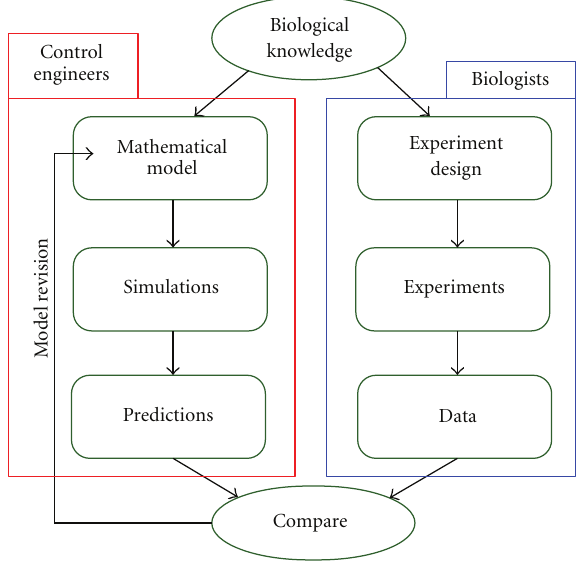
Figure 1: Typical analysis of biological